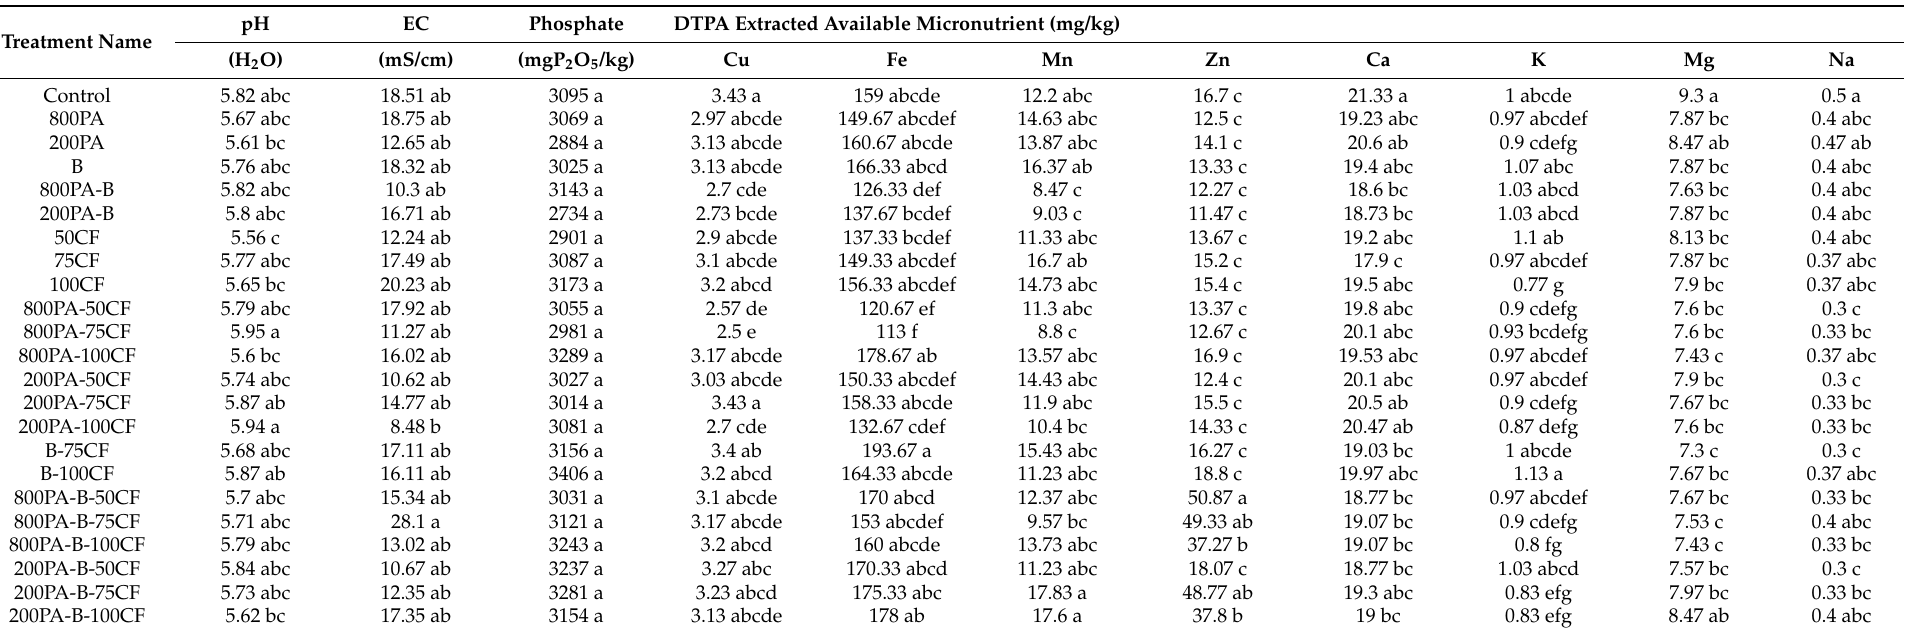
Table 7. Soil properties/nutrients of Komatsuna pots following application of different treatments. 800PA: pyroligneous acid diluted 800-fold; 200PA: pyroligneous acid diluted 200-fold; B: Biochar; 50CF: 50% chemical fertilizer; 75CF: 75% chemical fertilizer; 100CF: 100% chemical fertilizer. Different lowercase letters indicate significant difference at p < 0.05 as indicated by Tukey’s